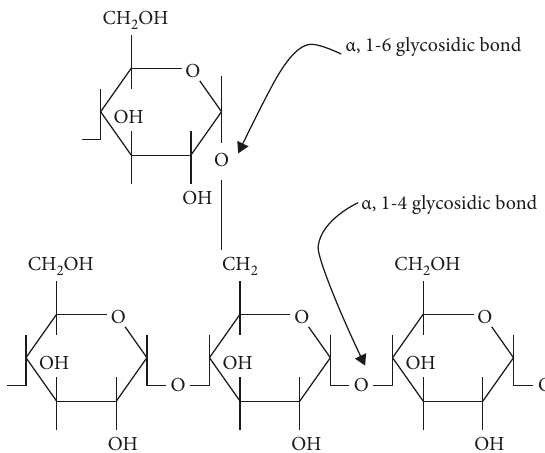
Figure 4: Amylopectin Polysaccharide (branched chain). Table 2: Degree based edge partition for n